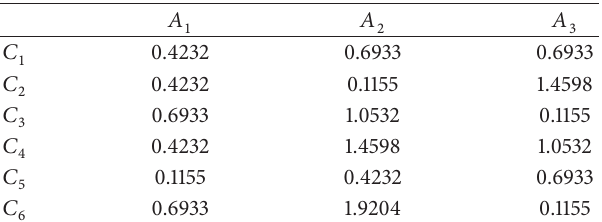
Table 9: Matrix of alternative scores with respect to